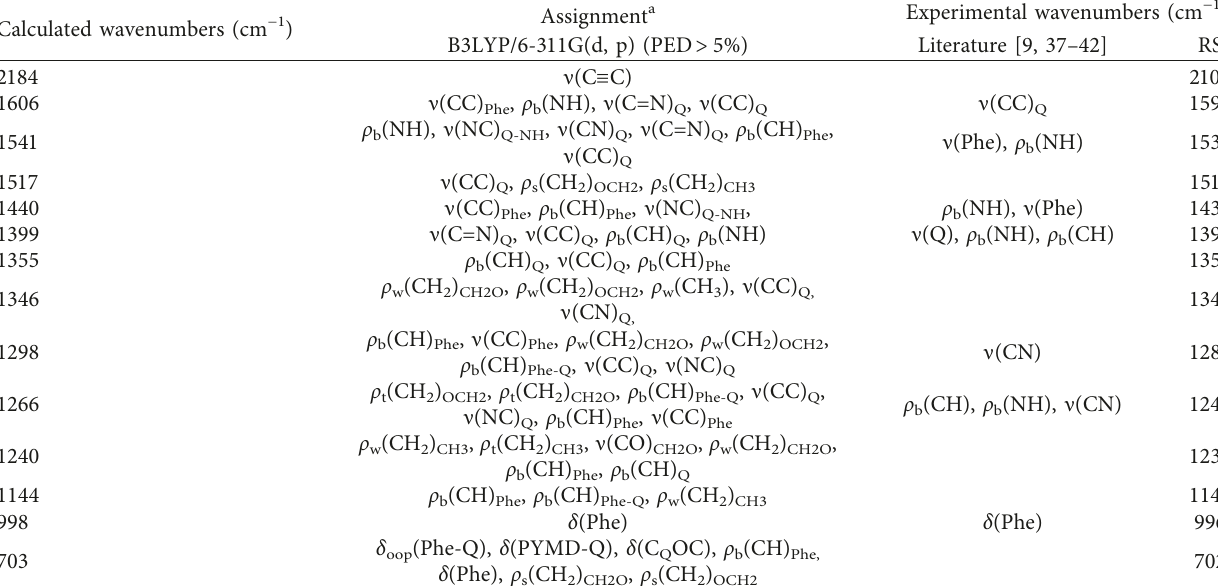
Table 3: Calculated (PCM model) and experimental wavenumbers for the RS spectra of erlotinib in the solution (pH 7). Calculated wavenumbers (cm − 1